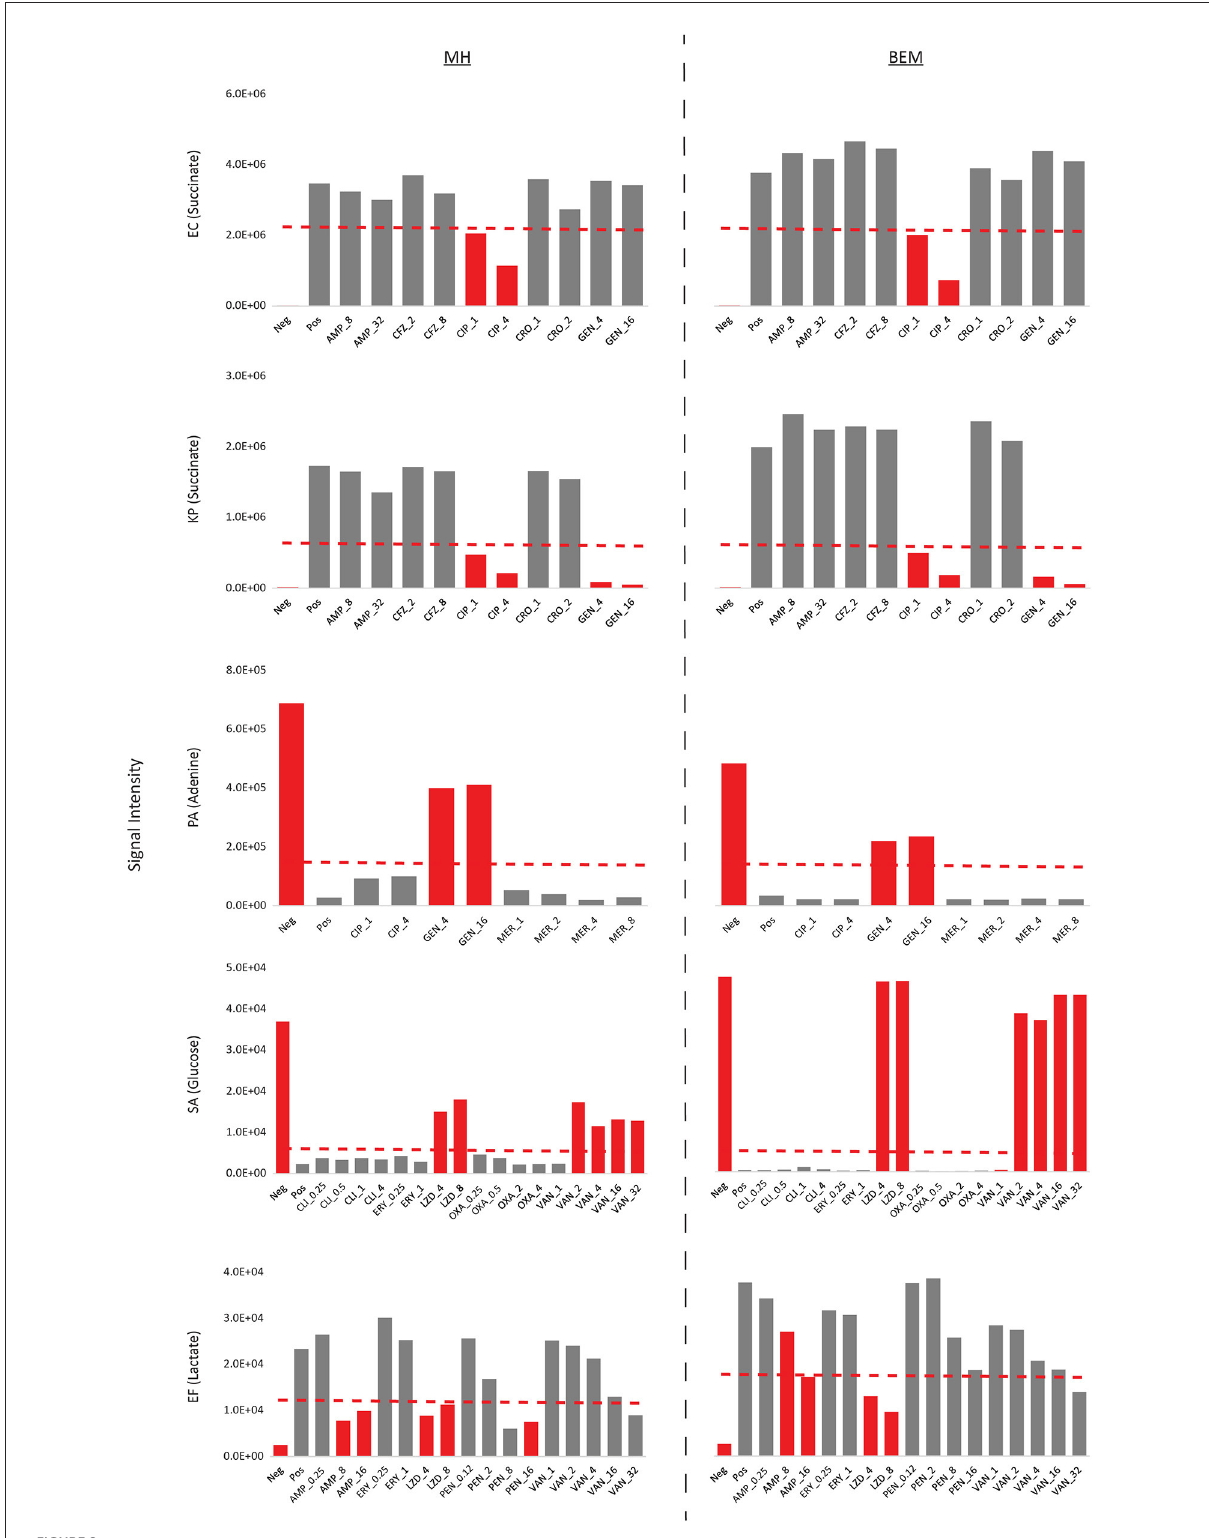
FIGURE8 Antibiotic susceptibility validation on BEM and MH II using metabolic inhibition profiles. Metabolic inhibition of select biomarkers in response to antibiotics were tested on bacterial isolates with known microdilution or Vitek2 AST profiles. Inhibition of biomarker production/consumption were in general agreement with microbroth dilution/Vitek2 calls, correctly identifying sensitive (gray bars) and resistant strains (red bars). Furthermore, changes in biomarker levels in both media were comparable. Sensitive vs. resistant threshold cutoffs are indicated in dashed red lines. Concentrations in antibiotics are provided as µ g/mL. Neg, uninoculated medium control; Pos, inoculated control with no added antibiotics; AMP, ampicillin; CFZ, cefazolin; CIP, ciprofloxacin; CRO, ceftriaxone; GEN, gentamicin; MER, meropenem; CLI, clindamycin;